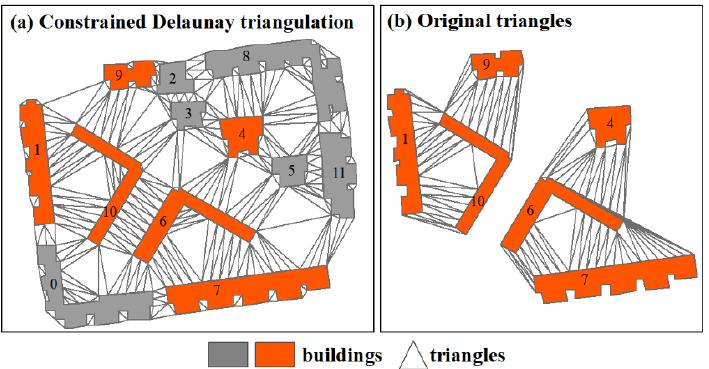
Figure 2. Examples of constrained Delaunay triangulation are shown for ( a ) triangulation computed for all buildings within each individual block, and ( b ) triangulation computed for pairs of adjacent buildings.